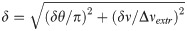
Discrimination levels of PD and orthogonal architectures.(A): Given two stimuli, activity maps are computed. The discrimination level ∥ΔA∥2 is given by the norm of the difference between the two maps (pixels with a difference smaller than 1% are not considered in the evaluation of the norm). (B) Median value (± mad) of ∥ΔA∥2 as a function of the distance δ between the presented stimuli in the parameter space δ=(δθ/π)2+(δν/Δνextr)2 for the dipolar (red) and orthogonal (blue) architectures. (C) Distribution of the difference between the median values (taken over stimuli) of the discrimination levels of dipolar and orthogonal architectures.